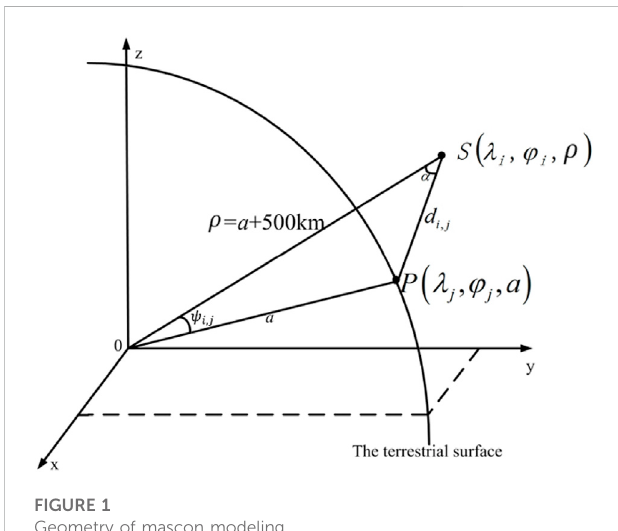
FIGURE 1 Geometry of mascon